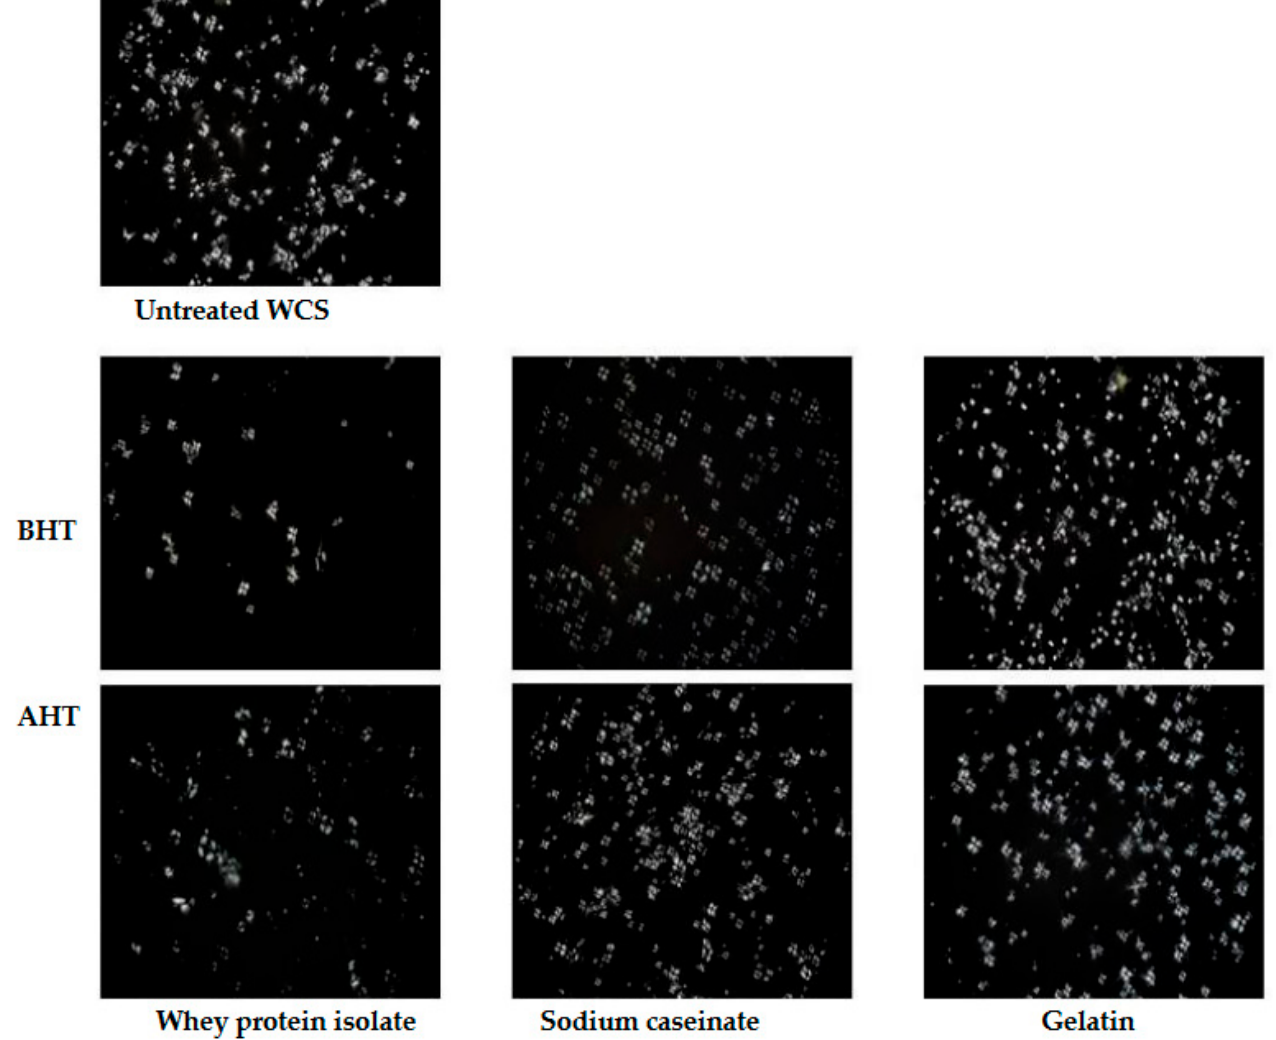
Figure 7. Light microscopy images captured for waxy corn starch (WCS) and in combination with the proteins prepared by the wet mixing method before and after dry heat treatment under a 50 ×